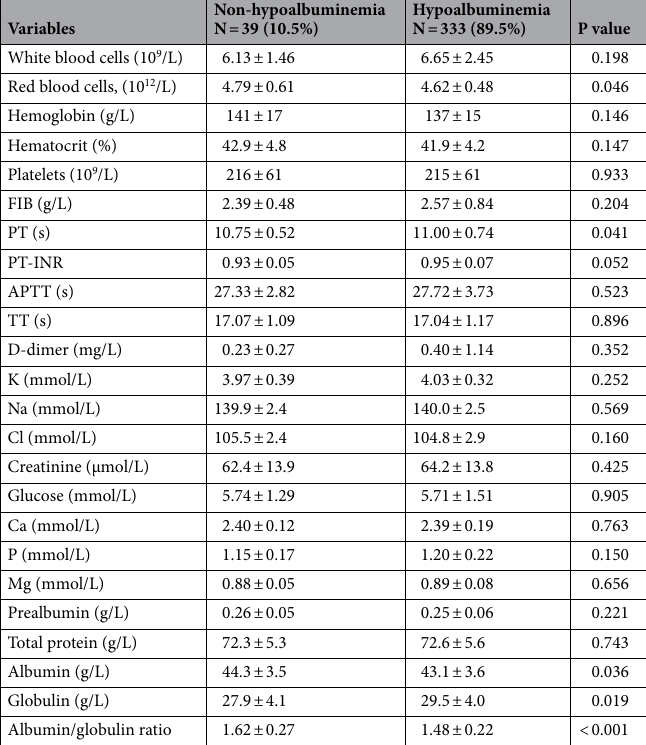
Table 2. Comparison of preoperative laboratory findings between with and without hypoabluminemia patients underwent craniotomy for brain tumor (mean ± SD). FIB fibrinogen, PT prothrombin time, PT-INR prothrombin time-international normalized ratio, APTT activated partial thromboplastin time, TT thrombin time, K potassium, Na sodium, Cl chloride, Ca calcium, P phosphorus, Mg magnesium.